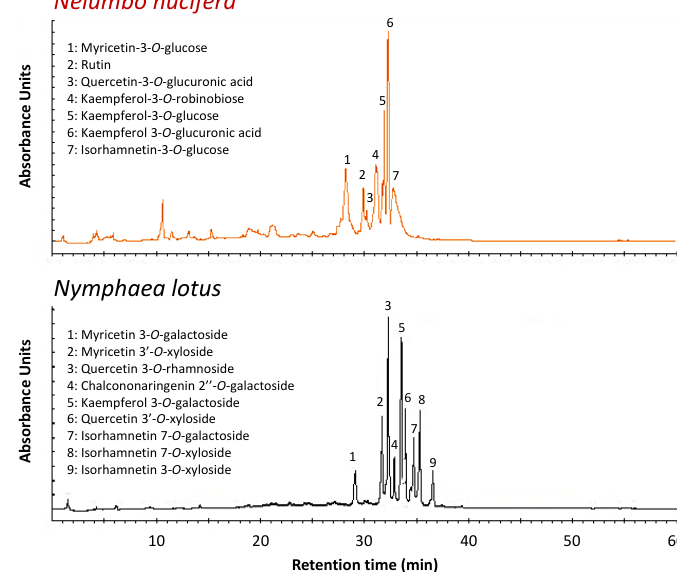
Figure 3. Representative high-performance liquid chromatography (HPLC) chromatograms of extracts from stamens of N. nucifera and N. lotus .